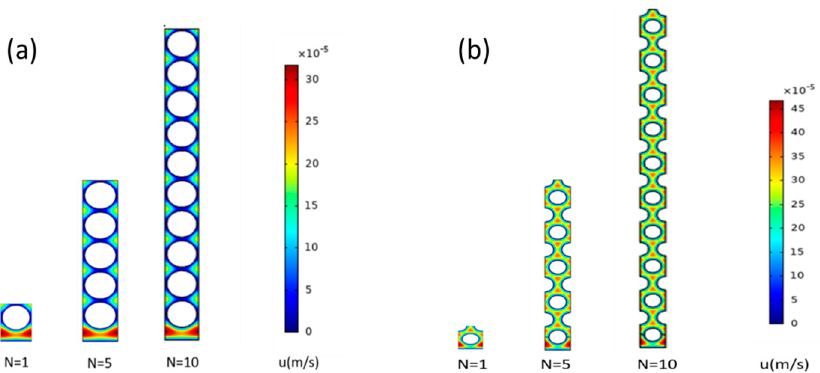
Figure 7. Sample velocity distributions for planar modules in the absence of permeation for: ( a ) square configuration ( ɸ = 0 .6, D/R f = 2) and ( b ) equilateral triangular configuration ( ɸ = 0 .4, D/R f = 2). Velocity decreases from red to blue.